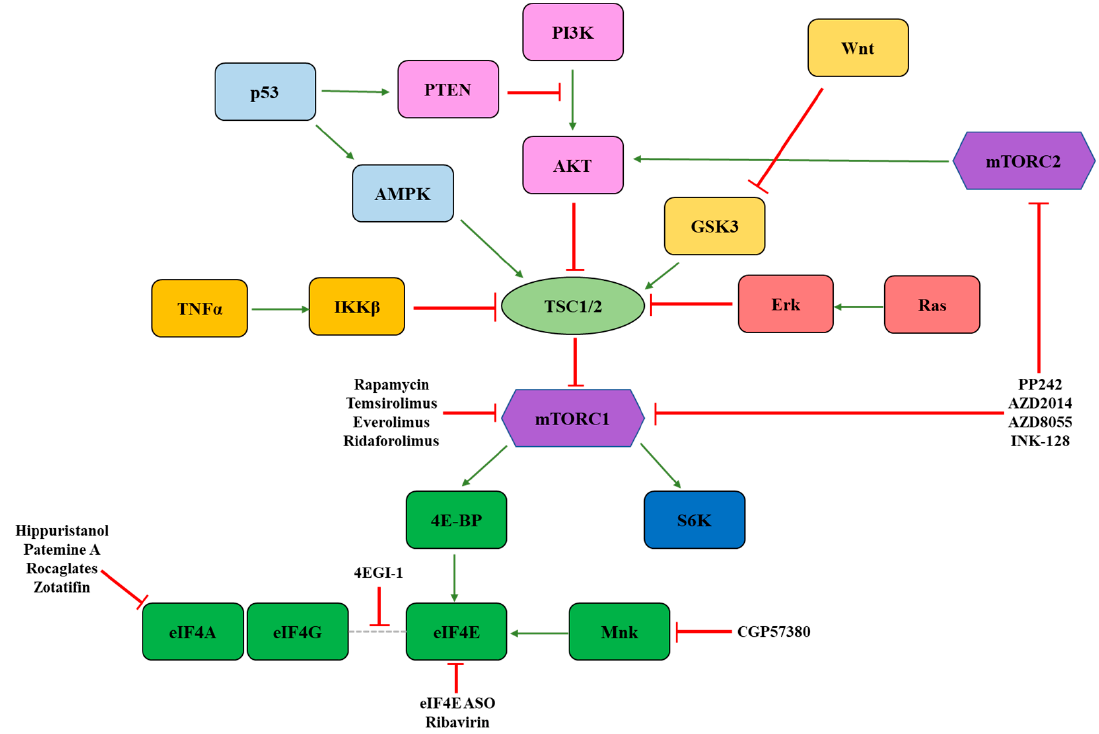
Figure 2. Overview of mTORC signaling and pathway inhibitors. mTORC1 is a funnel factor that receives inputs from numerous signaling pathways, including PI3K, Wnt, Ras, p53, and TNF α . mTORC1 transmits these signals to eIF4F through phosphorylation of 4E-BPs. Pathway inhibitors discussed in the text are indicated.